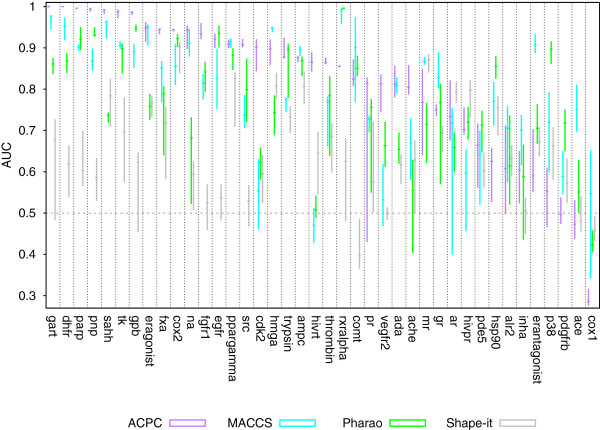
1st, 2nd and 3rd quartile plots forACPC, MACCS, Pharao and Shape-it on all queries of the “1conf” dataset. For clarity, targets are sorted on the x axis by decreasing median value obtained by ACPC. The red dotted horizontal line at AUC = 0.5 indicates random performance.